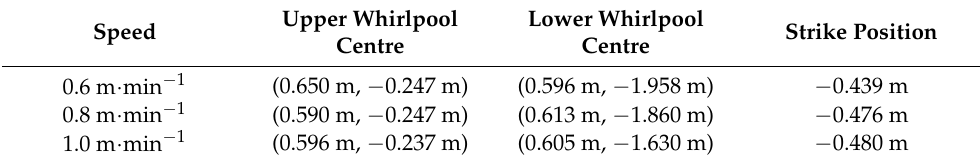
Table 2. Whirlpool core positions and strike locations under different casting speeds. Speed